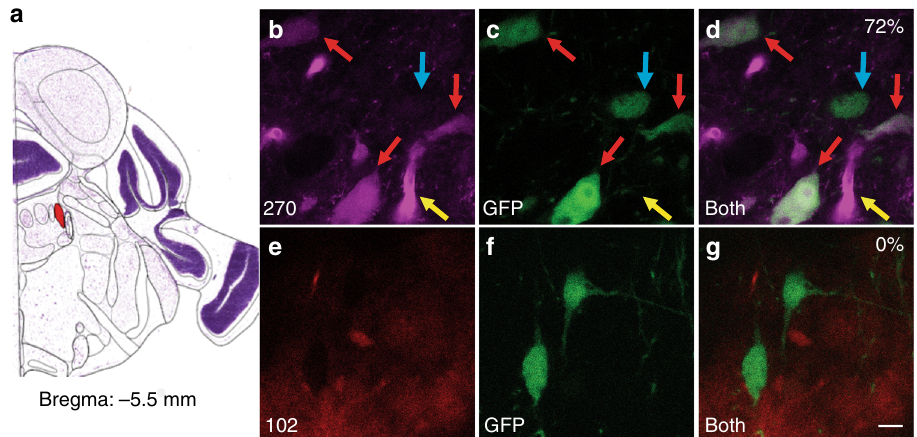
Fig. 3 FFN270 labels NE neurons in the locus coeruleus. a Atlas image highlighting in red the location of the locus coeruleus in the mouse brain (Bregma: − 5.5 mm, Allen Institute) 51 . b – d FFN270 (magenta, b ) effectively colocalized with the noradrenergic label TH-GFP (green, c ), resulting in a 72% colocalization of noradrenergic cell bodies (labeled by red arrows, 62/86 cells, 6 animals). Cells that did not colocalize are highlighted with a blue arrow, and blood vessels are highlighted with a yellow arrow. e – g When repeated with FFN102 (red, e ), no colocalization was observed with TH-GFP ( f ). Images obtained by 2-photon microscopy in acute mouse brain slice (for imaging parameters, see Methods). Scale bar: 10 µ